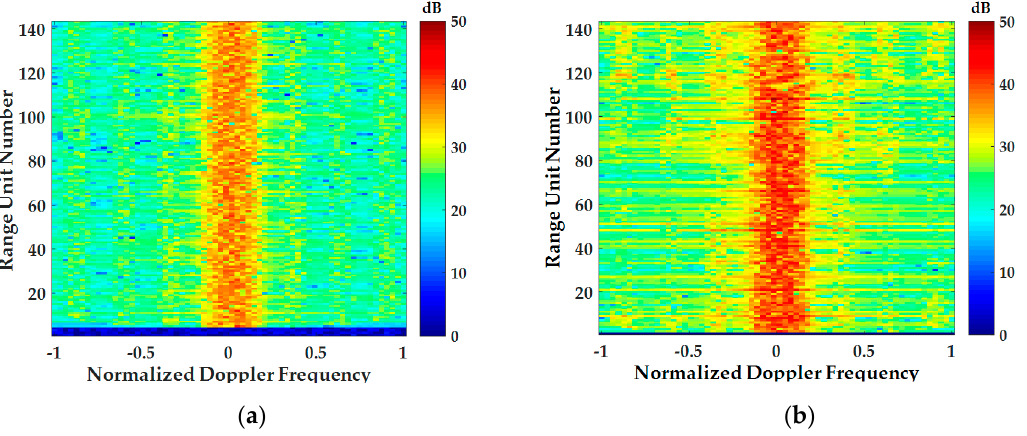
Figure 12. Comparison of range Doppler spectrum: ( a ) The range Doppler spectrum obtained from the Gaussian statistical model homogeneous clutter simulation method; ( b ) The high-fidelity inhomogeneous clutter simulation method proposed in this paper.